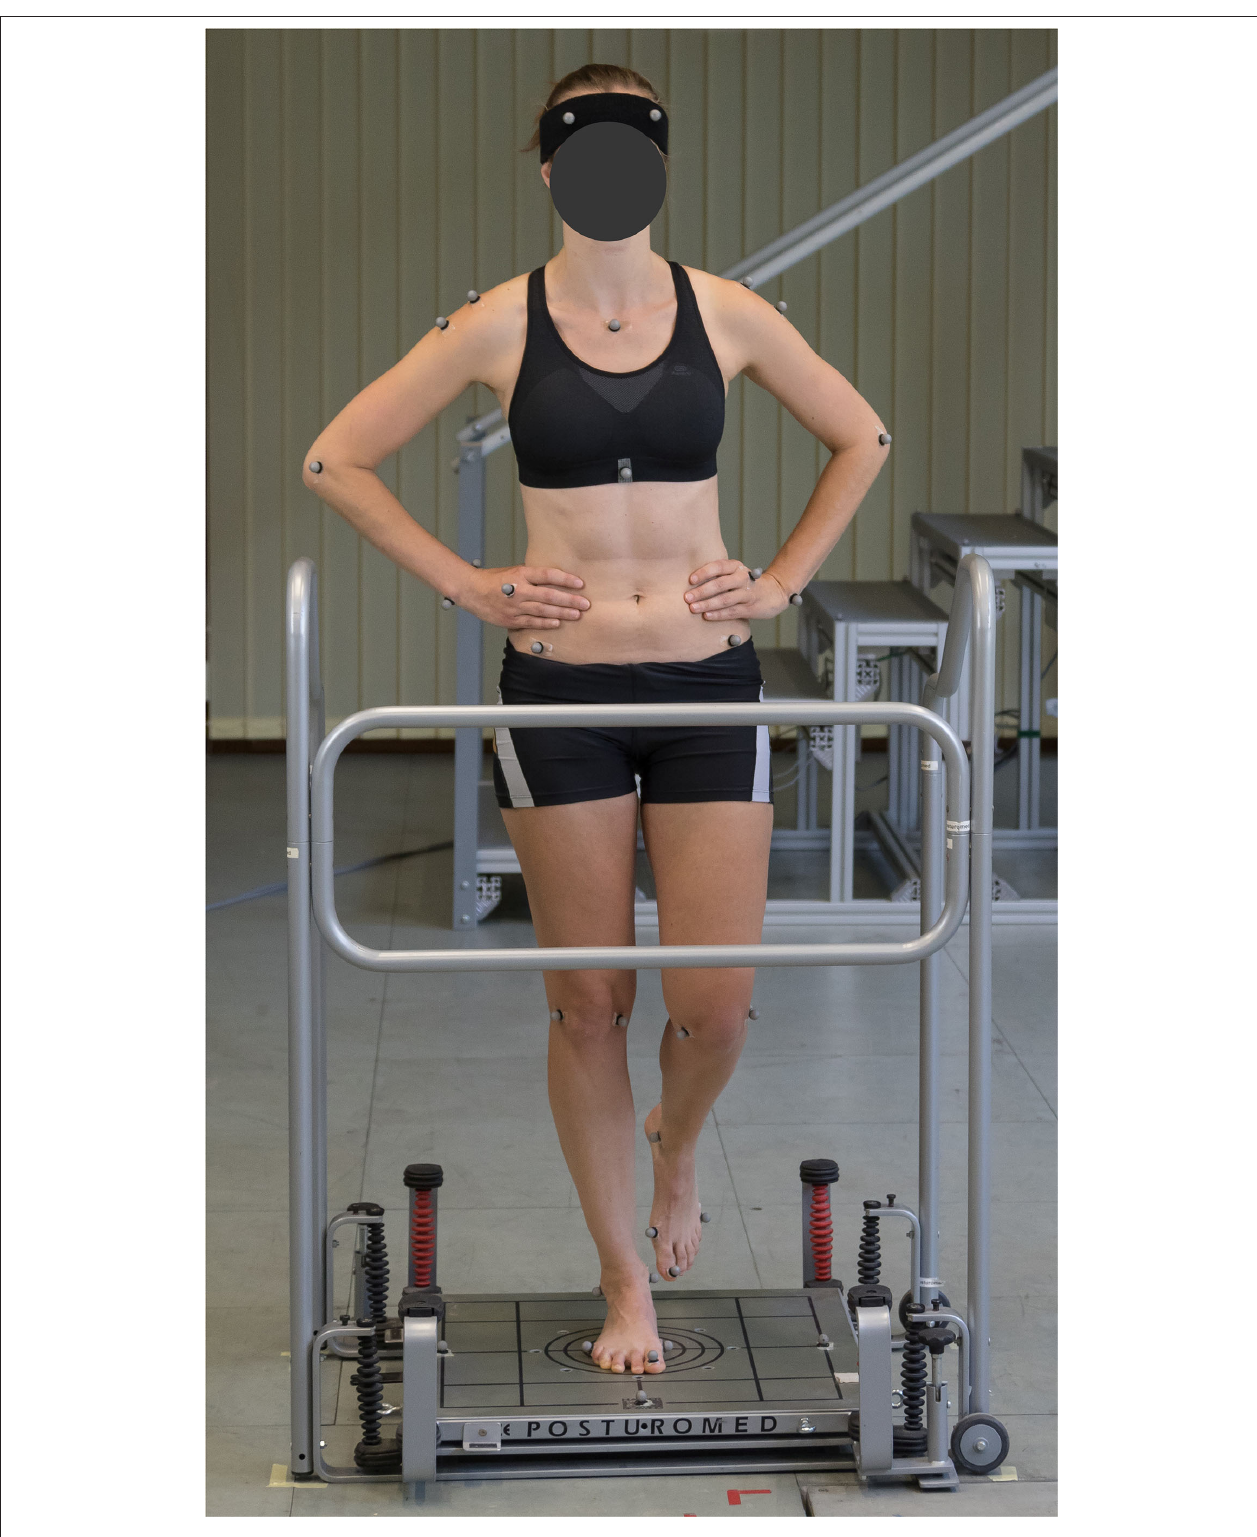
FIGURE 1 | Participant during single-leg stand on the Posturomed oscillating platform.